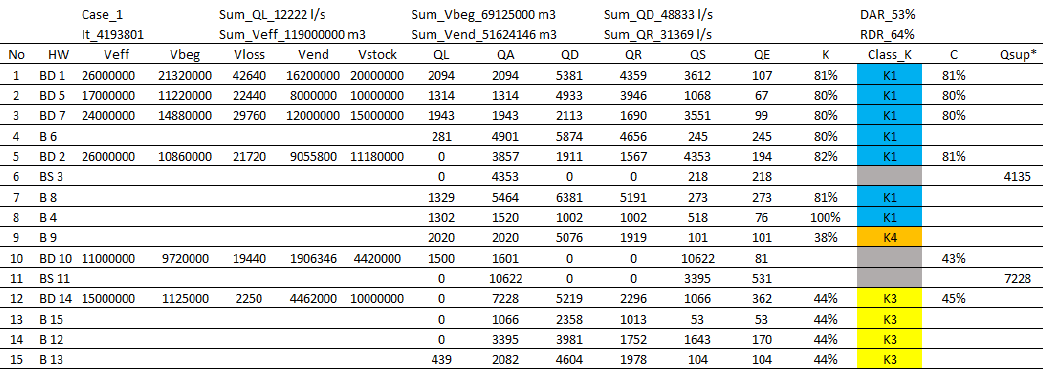
Figure 11. Computation output with equalization method.